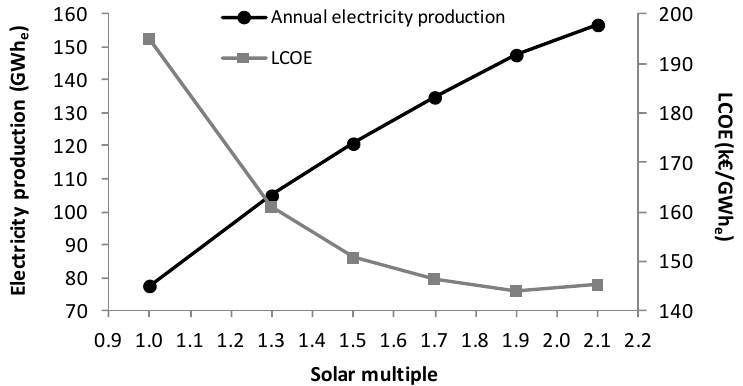
Figure 11. Annual net electricity production and levelized cost of energy as a function of the solar multiple.